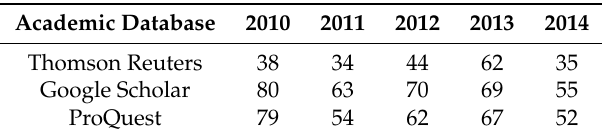
Table 1. Number of research articles in the last five years for three academic databases and search engines.